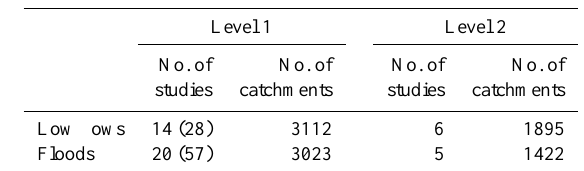
Table 2. Number of studies (in brackets number of results) and number of catchments used. Level 1 refers to an assessment of the average performance of studies, Level 2 to an assessment of the per- formance for individual